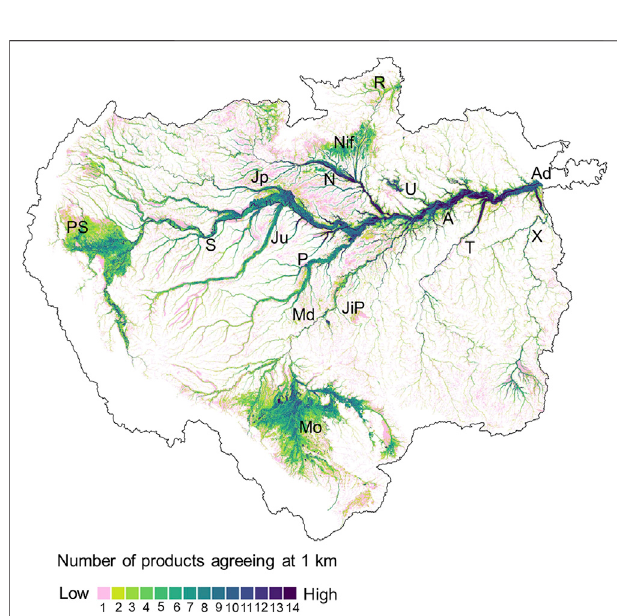
FIGURE 2 | Hydrological Amazon basin with inundated areas shown for basin < 500 m asl based on different remote sensing and analysis techniques. Each1 kmpixelshowsthenumberofbasin-scaleinundationdatasets(totalof 14 products were assessed) that agree that the pixel is fl oodable, according to Fleischmann et al. (2021). Rivers and wetlands mentioned in the text: Solimões — S, Madeira — Md, Negro — N, Japurá — Jp, Juruá —